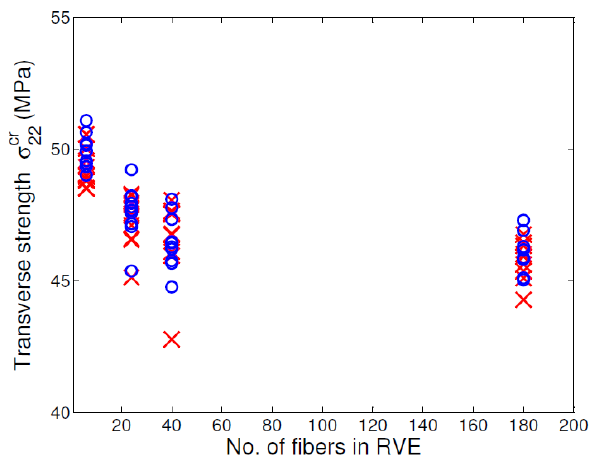
Figure 19. Comparison of transverse unit cell strength with variability in matrix tensile strength (red) with the case of uniform matrix tensile strength (blue), both cases as functions of unit cell